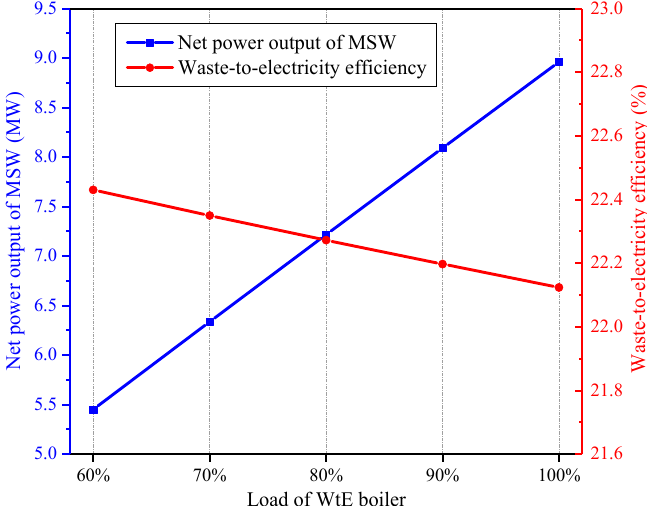
Figure 7. E ff ect of the WtE boiler load on the performance of the integrated WtE Figure 7. Effect of the WtE boiler load on the performance of the integrated WtE system.